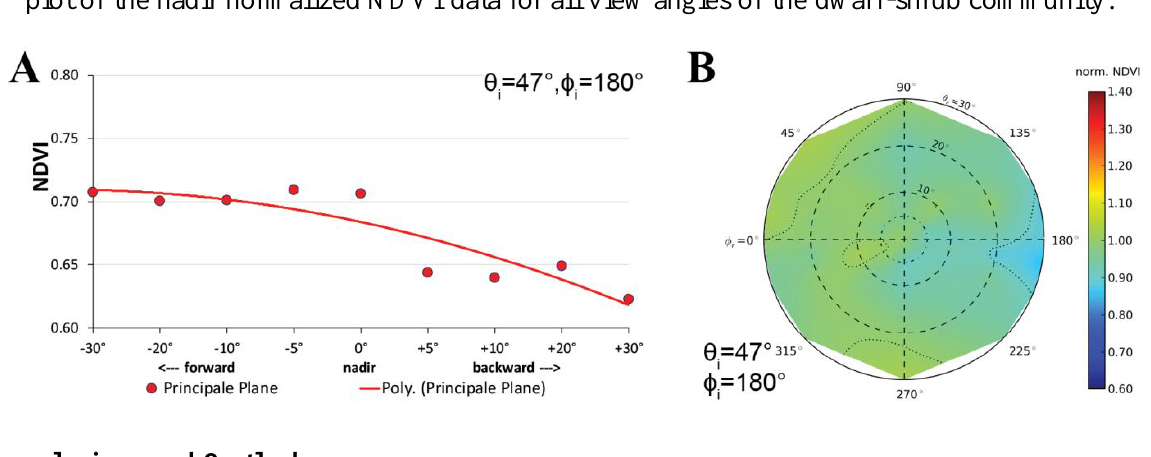
Figure 13. ( A ) NDVI for various view zenith angles in the solar principal plane; ( B ) Polar plot of the nadir normalized NDVI data for all view angles of the dwarf-shrub